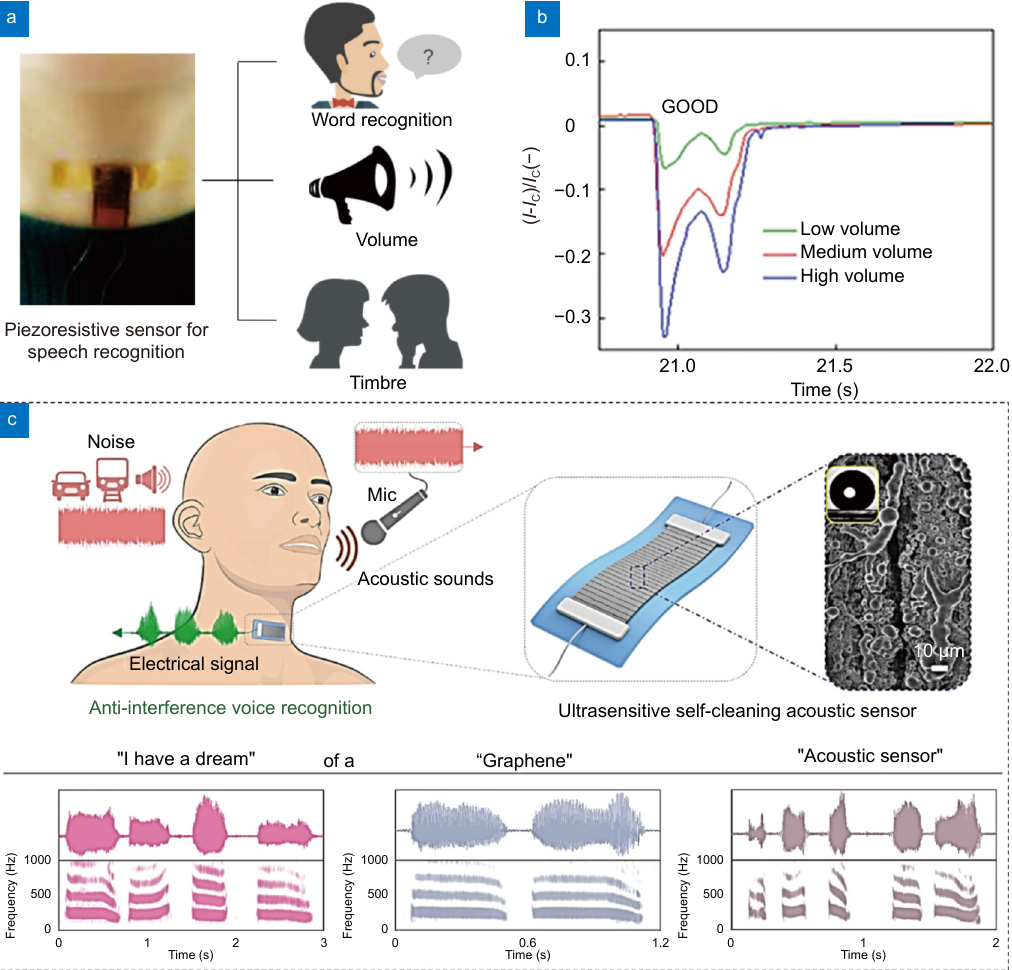
Fig. 12 | Piezoresistive sensor for intelligent speech recognition. ( a ) Piezoresistive detection of sound (e.g. word recognition, volume detec- tion, and voice recognition) 68 . ( b ) Response of a MXene-based piezoresistive sensor to the audio outputs at different volumes 162 . ( c ) Anti-interfer- ence voice recognition by a skin-attachable piezoresistive sensor 165 . Figure reproduced with permission from: (a) ref. 68 , (b) ref. 162 , (c) ref. 165 , American Chemical